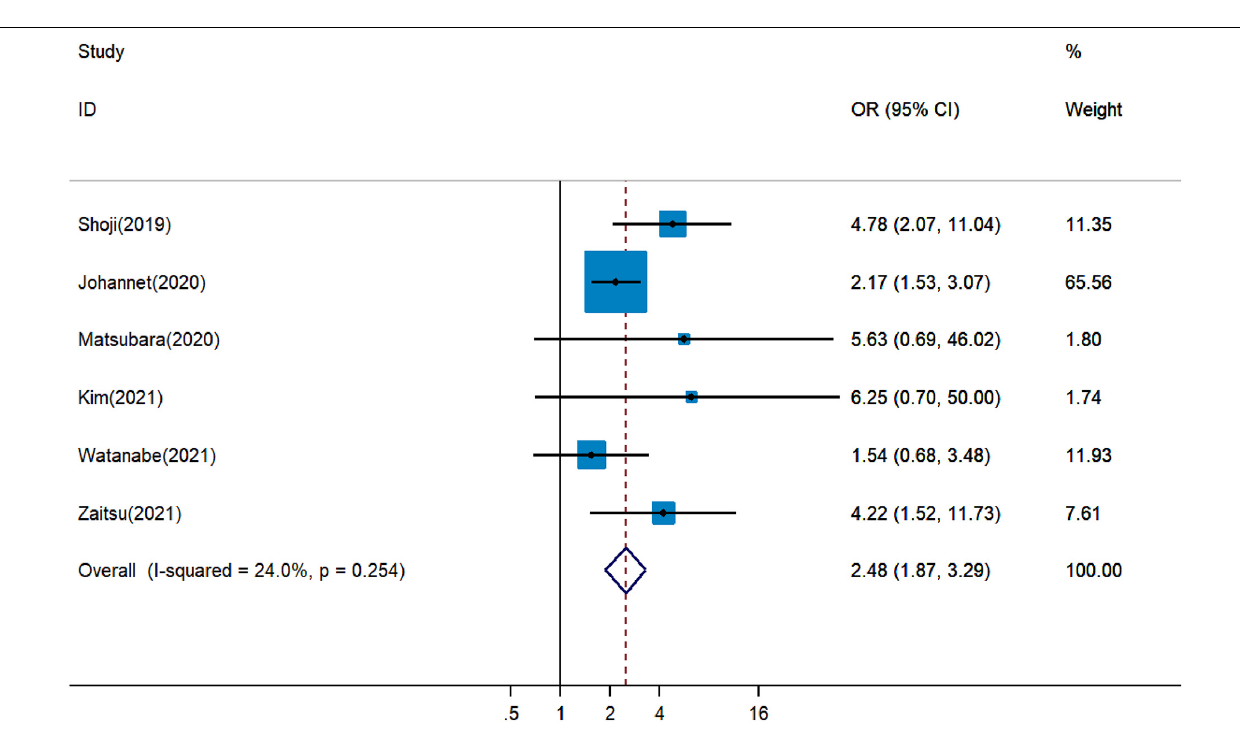
FIGURE 4 | Meta-analysis of impact of PNI on disease control rate of patients treated with immune checkpoint inhibitors.